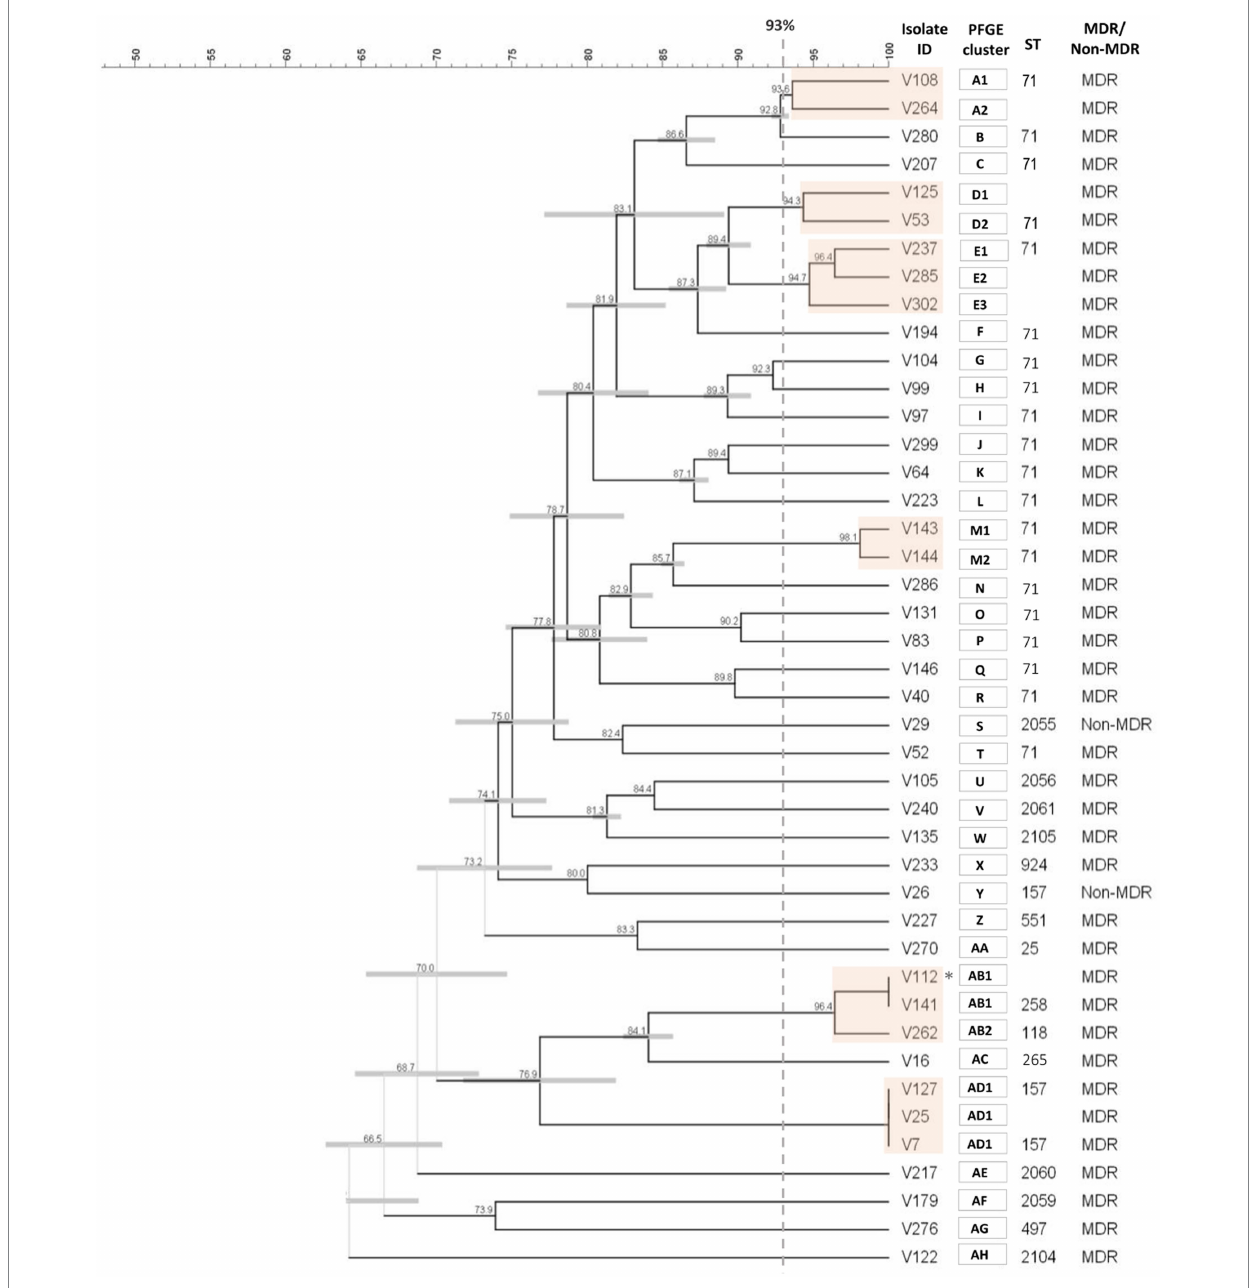
FIGURE 3 Cluster analysis of the Sma I macrorestriction profiles of the 43 MRSP isolates. The dendrogram was constructed with DICE and UPGMA algorithms using an optimization of 0.5% and tolerance of 1.5%. PFGE types (orange boxes) were defined by a cut-off value ≥ 93% of similarity (gray dashed line). Each type is designed by capital letter(s), with numbers indicating subtypes. * Isolates V112 and V141 were collected from the same animal. Because they were pheno- and genotypically indistinguishable; isolate V112 was not included in the final